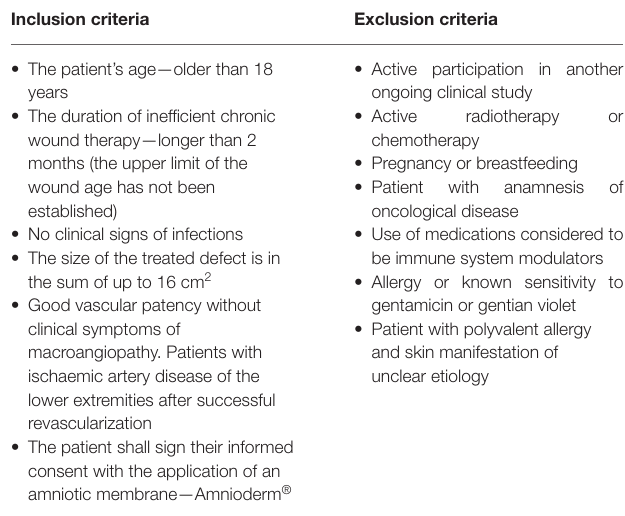
TABLE 1 | Major inclusion and exclusion